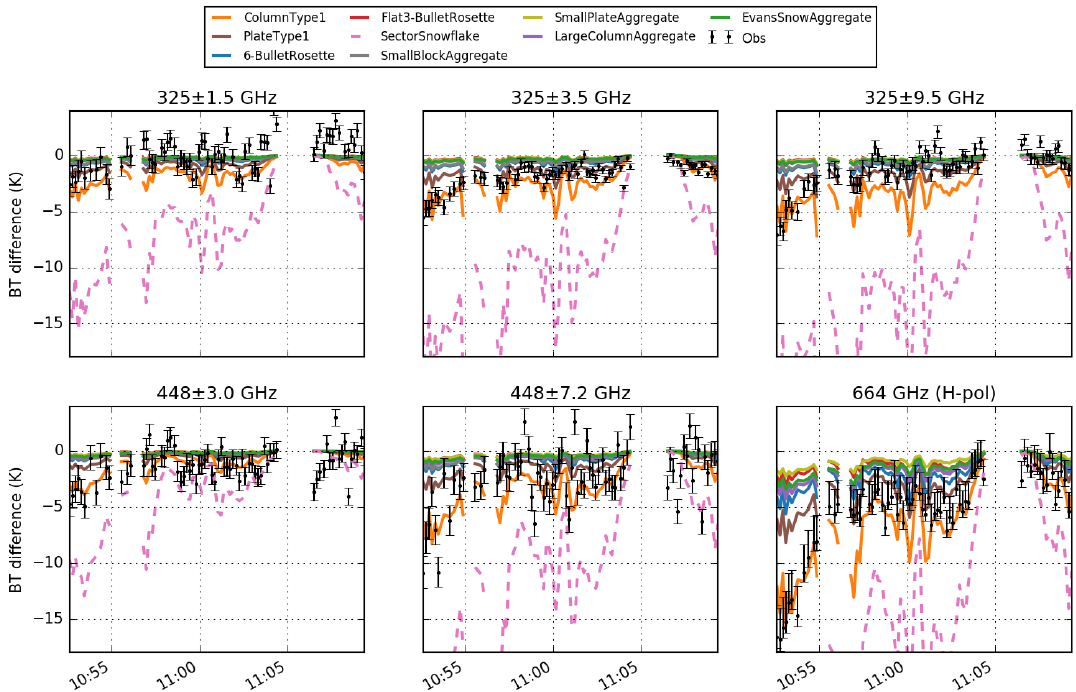
Figure 9. Time series of measured and simulated cloud-induced brightness temperature differences for B939. The dashed lines indicate habits that are not consistent with the in situ bulk